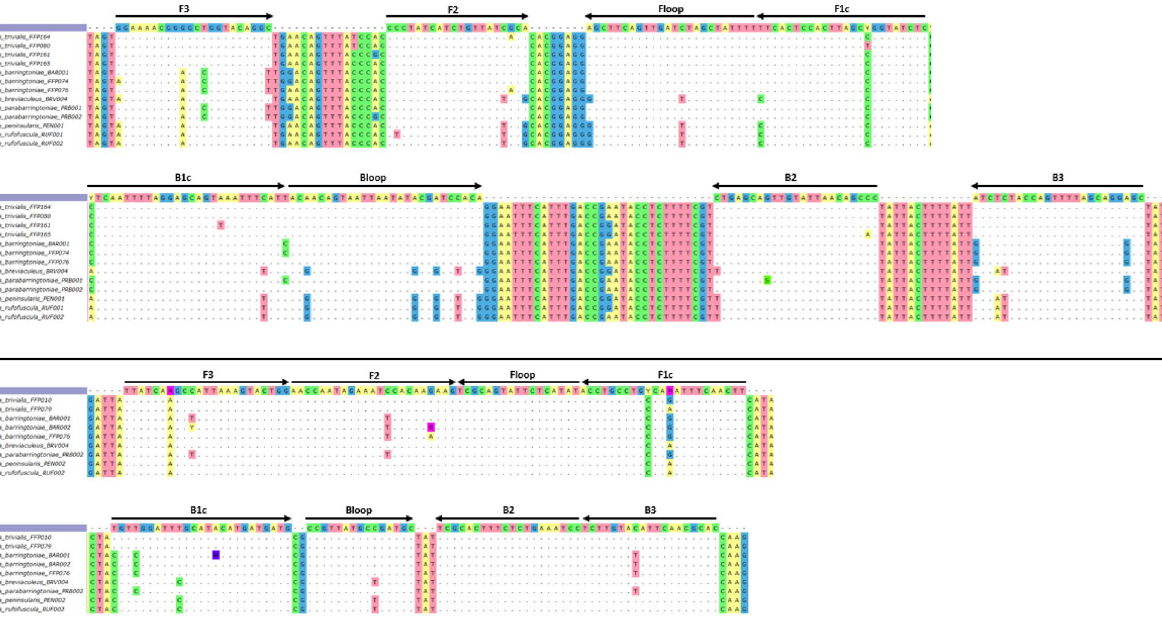
Figure 4. ( a ) DNA sequence alignment displaying ( a ) 260 bp region targeted in the BtrivCOI barcode LAMP assay; and ( b ) 176 bp target region in BtrivEIF3L LAMP assay. Genotypic variation in target and